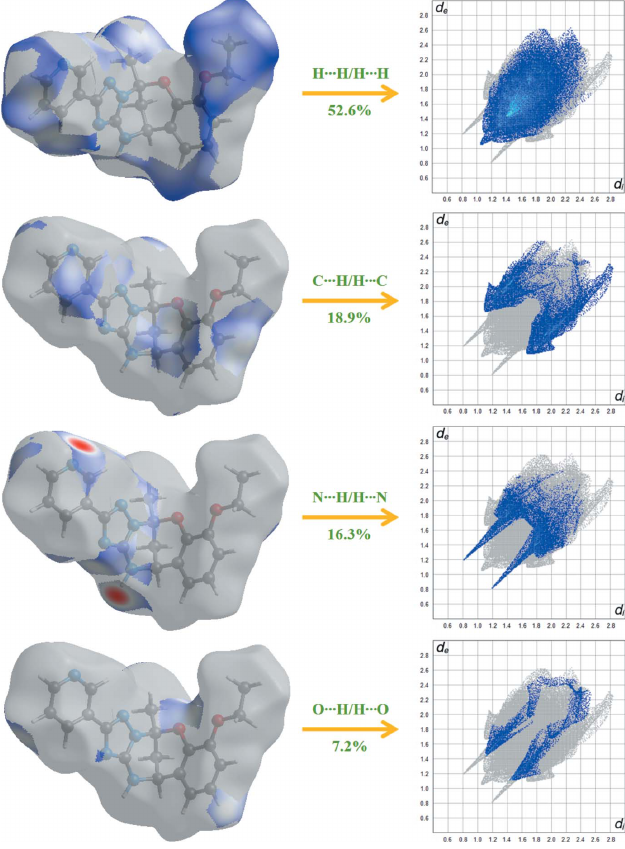
Figure 6 Two-dimensional fingerprint plots with a d norm view of the H (cid:2)(cid:2)(cid:2) H/H (cid:2)(cid:2)(cid:2) H (52.6%), C (cid:2)(cid:2)(cid:2) H/H (cid:2)(cid:2)(cid:2) C (18.9%), N (cid:2)(cid:2)(cid:2) H/H (cid:2)(cid:2)(cid:2) N (16.3%) and O (cid:2)(cid:2)(cid:2) H/ H (cid:2)(cid:2)(cid:2) O (7.2%) contacts in the title compound.